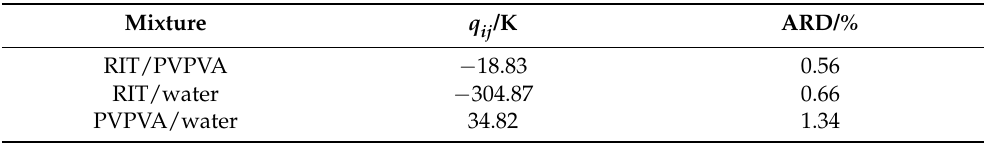
Table 3. Kwei interaction parameters fitted to glass transition temperatures of single-phase binary mixtures of RIT, PVPVA, and water measured in this work. Mixture q /K ARD/ % ij RIT/PVPVA